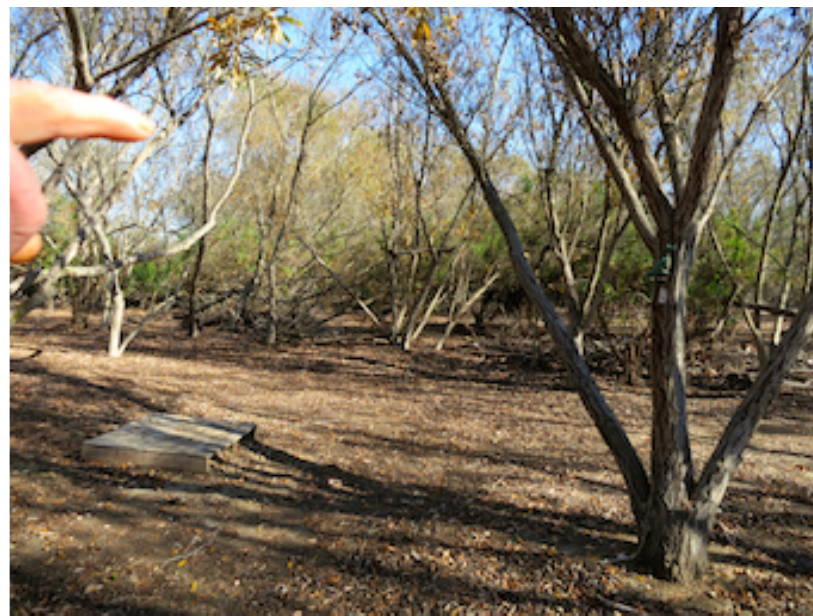
Figure 4. Henry pointing out the location of his camp